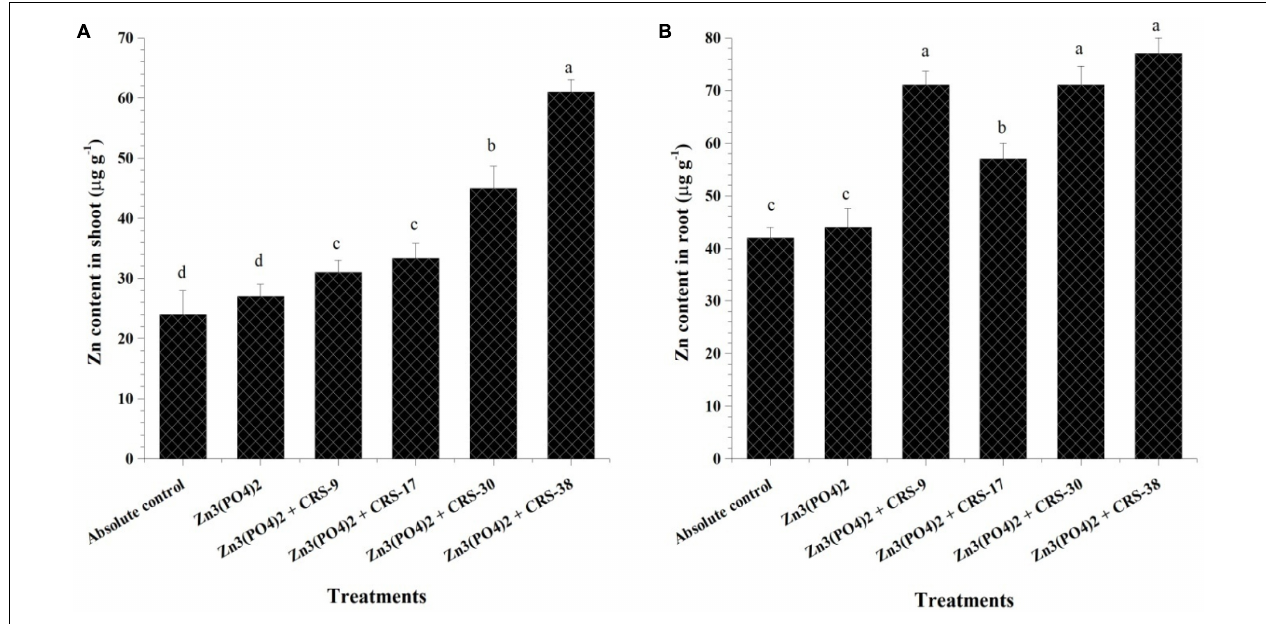
FIGURE 5 | Estimation of zinc content in (A) shoots and (B) roots of inoculated and un-inoculated plants harvested after 30 days. Data are mean ( n = 5), and vertical bar represents standard deviation. Data with different letters show significant difference in column data in the randomized block design test at p < 0.05 under Duncan’s multiple range